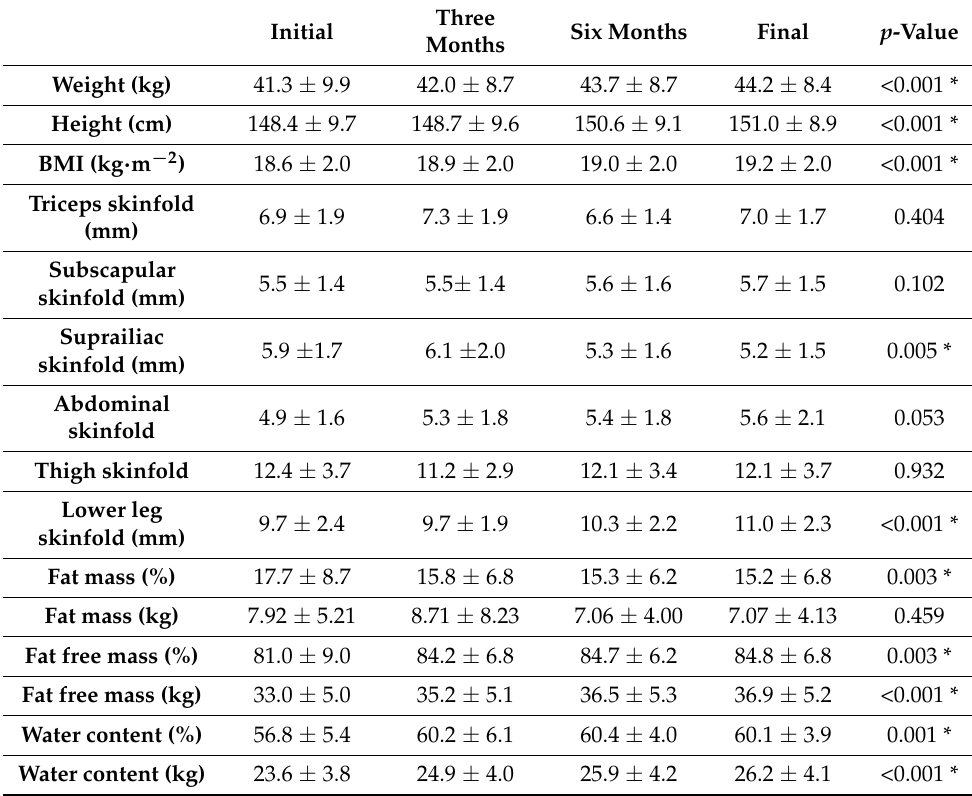
Table 6. Changes in gymnasts’ anthropometric parameters during the study. Three Six Months Final p Initial Months